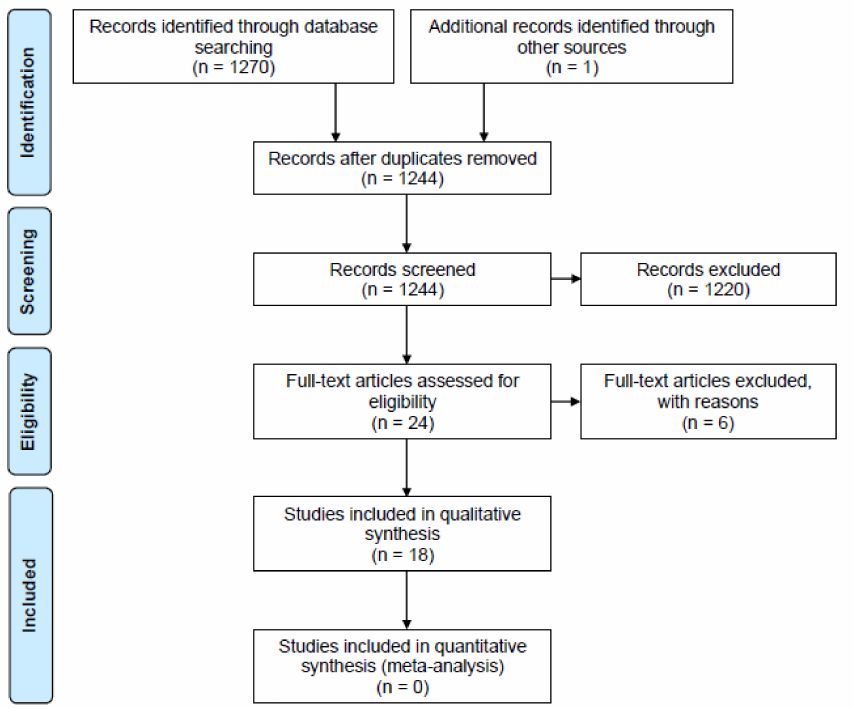
Figure 1. Flowchart of systematic literature search according to PRISMA guidelines.